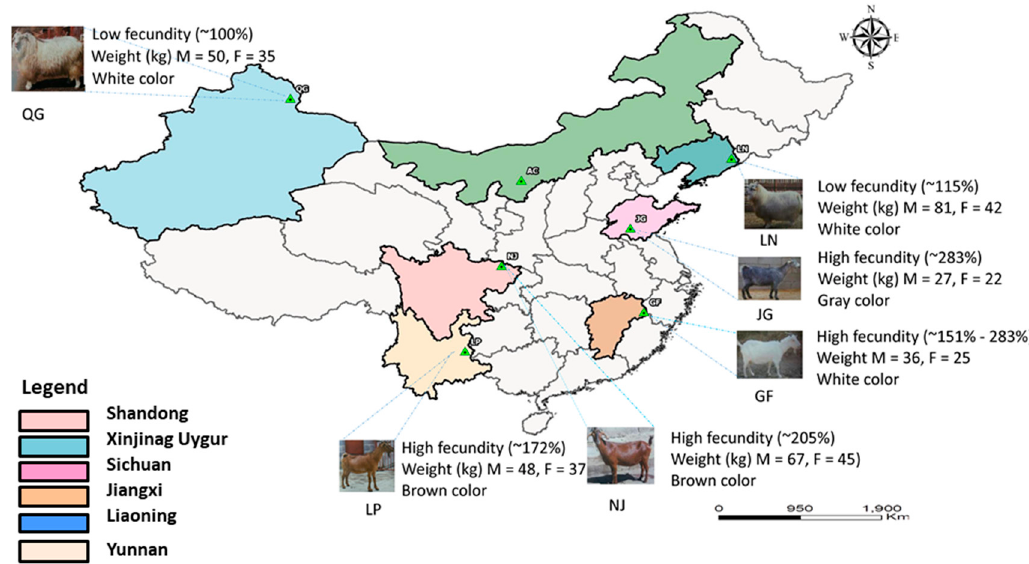
Figure 1. Geographic distribution and phenotypic characteristics of the six goat populations in China. M, Male; F, Female; QG, Qinggeli; LP, Luoping Yellow; NJ, Nanjiang; LN, Liaoning; JG, Jinning Grey; GF, Guangfeng.